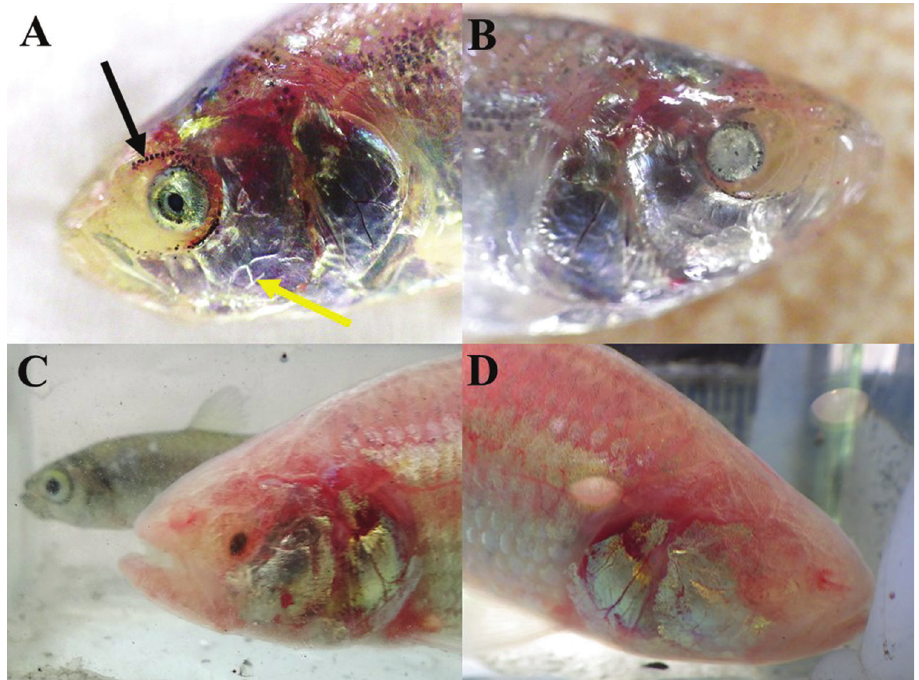
Figure 3. High variability in the eye and pigmentation level within the population inhabiting Chiqu- itita Cave. A eye size reduced B pupil closed C in the foreground a troglomorphic fish with reduced and embedded eyes and in the background a pigmented fish with large eyes D eyes and pigment mostly absent. Black arrow highlights pigmented cells in some troglomorphic fish and yellow arrow highlights fragmentation of the suborbital bone